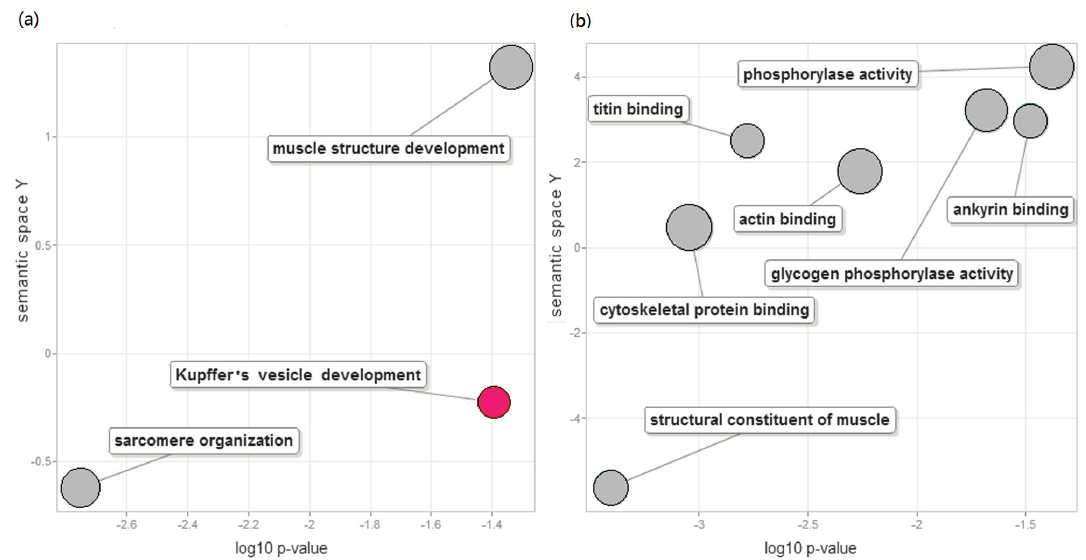
Figure 5. Significantly enriched functions in DEGs. Enriched biological processes ( a ) and molecular functions ( b ) were projected to 2D semantic spaces. Grey circles and red circles corresponded to significantly enriched GO terms found in white skin and red skin, respectively. The x -axis represented the log10 corrected p by the Bonferroni procedure. The semantic space was generated by the REVIGO web service with all enriched GO terms found in